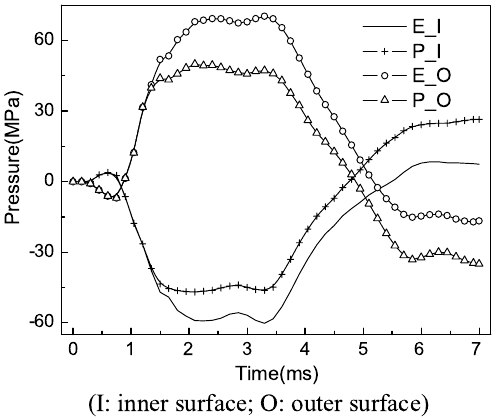
Fig. 19. Time histories of pressure at the center on inner surface and outer surface for different material models of windshield.